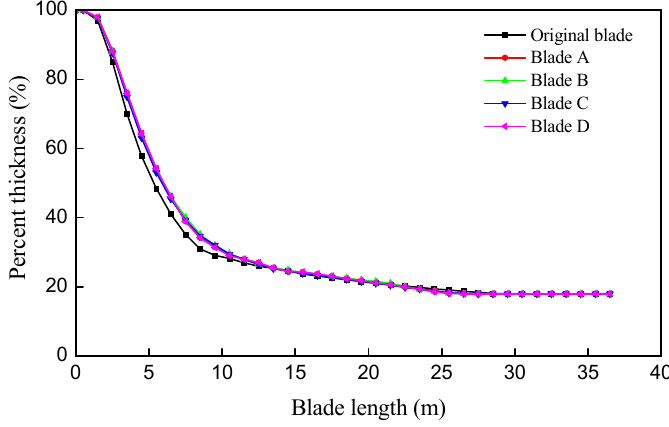
Figure 15. Comparison of percent thickness distributions.